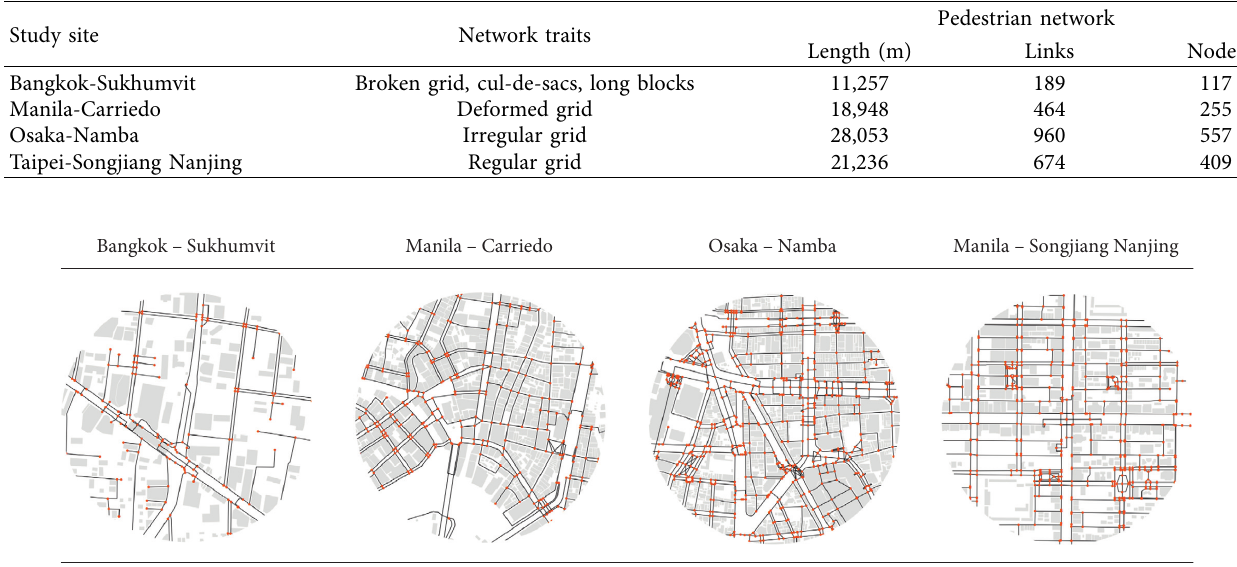
Table 1: Pedestrian network characteristics.